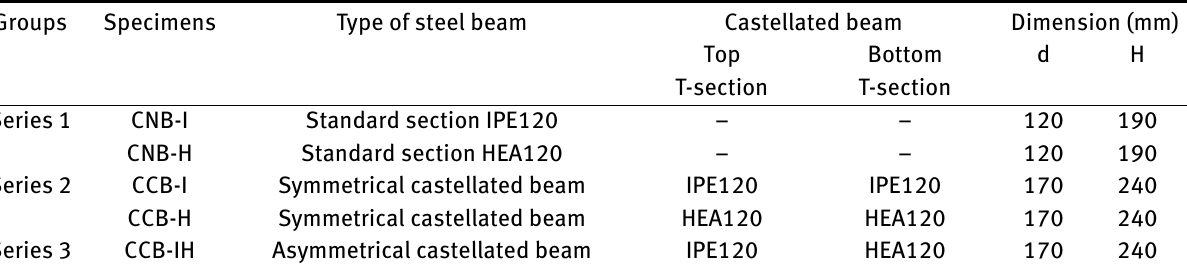
Table 1: Details of steel beams used in the composite specimens Groups